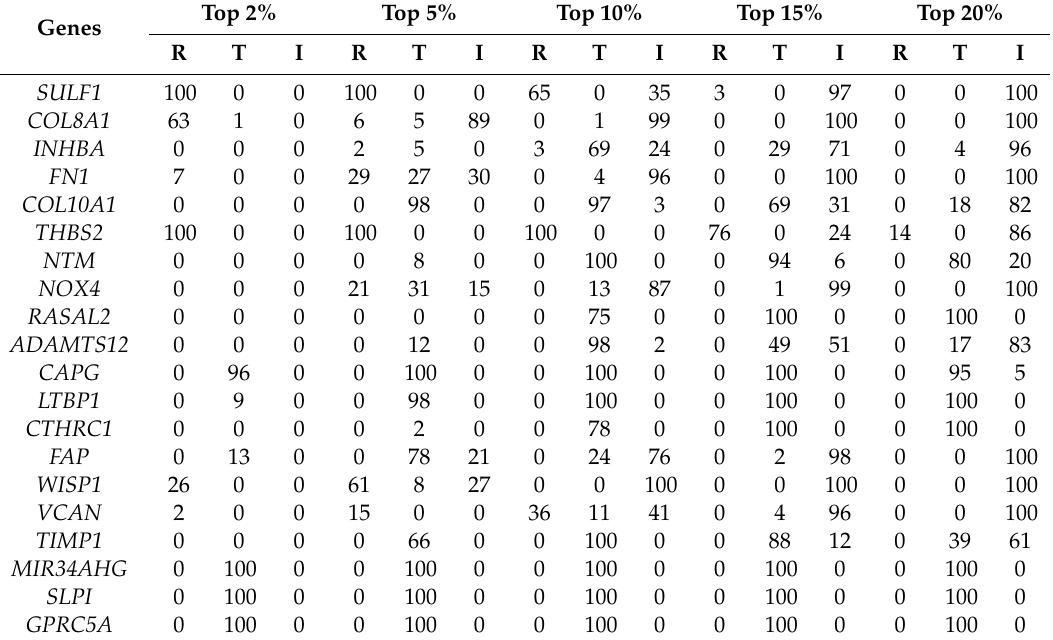
Figure 5. GRN generated from the application of PLSNET on pancreatic ductal adenocarcinoma (PDAC) dataset. Table 3. Frequencies of di ff erent genes appearing as Regulatory (R), Target (T), or Intermediate (I) gene for di ff erent threshold values for the PDAC